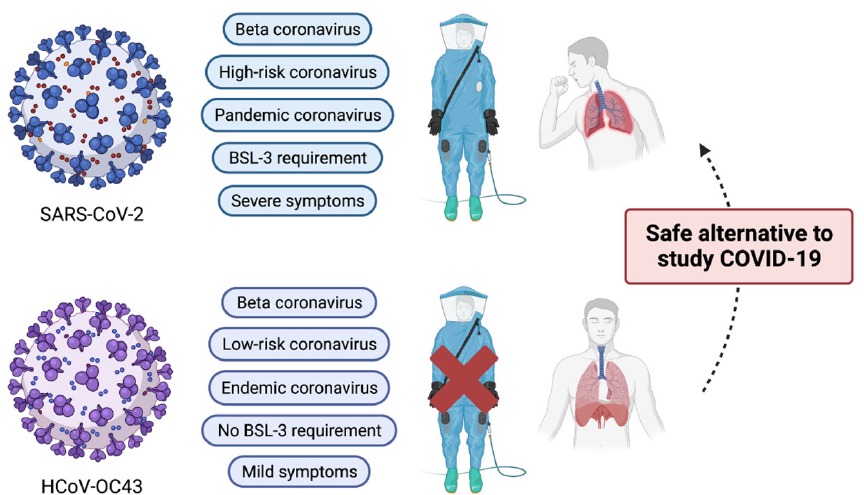
Figure 1. Comparison of major characteristics of SARS-CoV-2 and HCoV-OC43. Despite belonging to the same beta coronavirus, HCoV-OC43 is classified as an endemic coronavirus. In addition, due to its mild clinical symptoms, its biology can be studied under the BSL-2 research setting. Therefore, HCoV-OC43 can serve as a good research alternative to SARS-CoV-2. This illustration was created with BioRender.com.